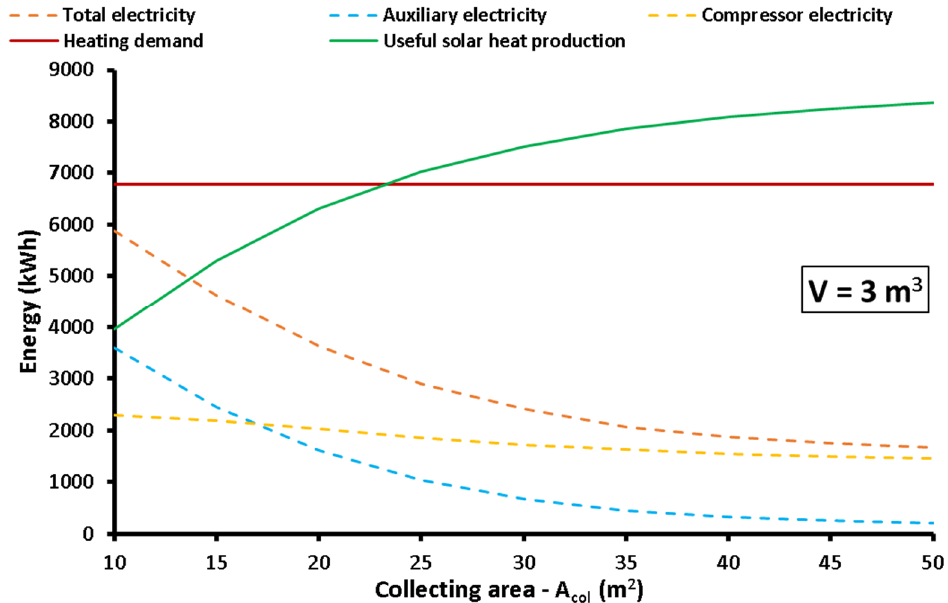
Figure 9. Variation in energy quantities for different collecting areas with the storage tank volume at 3 m 3 .